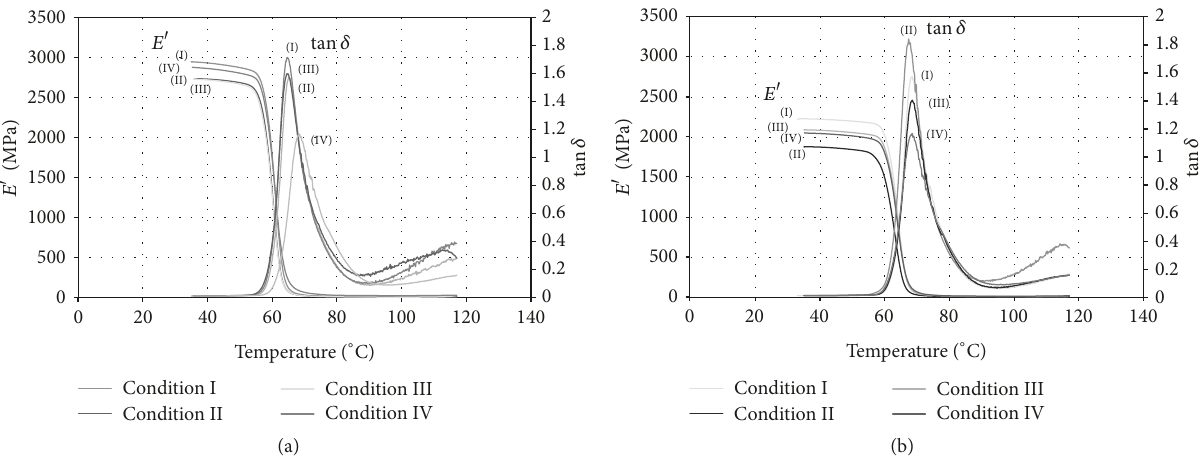
after 60 s, while notched specimens present stretching in the center region due to the stress concentrator (e.g.,